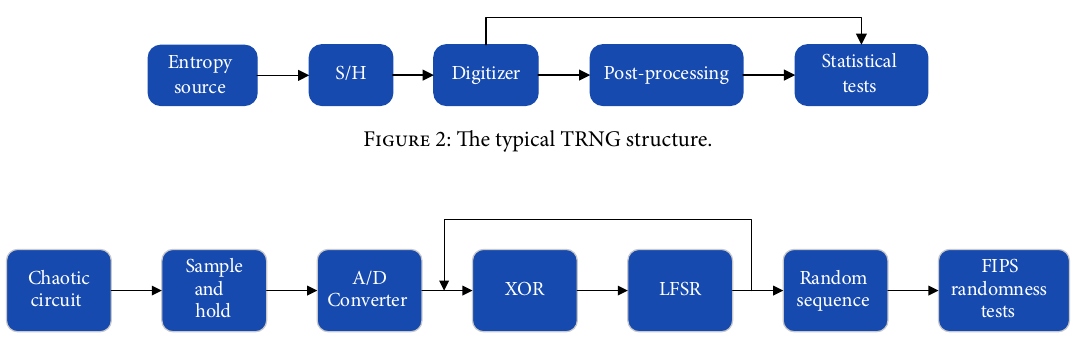
Figure 3: True random number generation from the Chua’s circuit core proposed by Moqadasi and Ghaznavi-Ghoushchi .